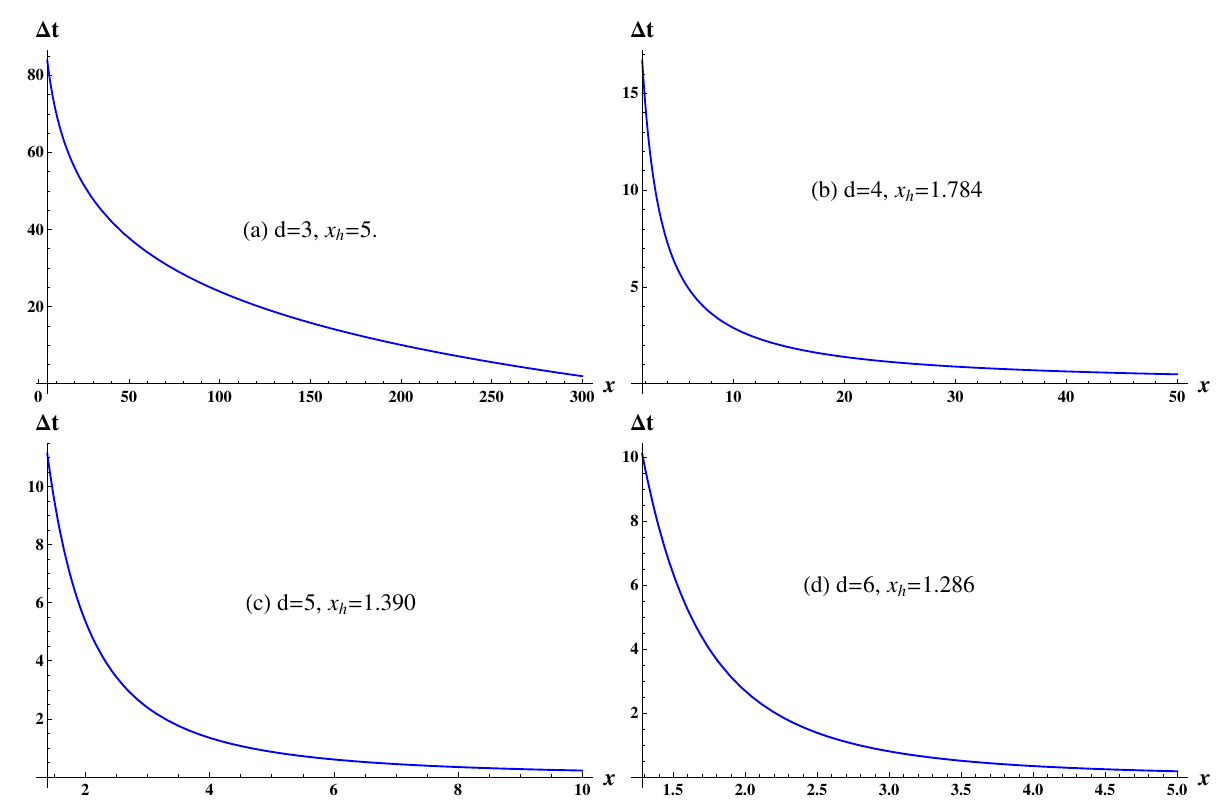
Figure 6. Excess time delay for a higher dimensional Schwarzschild black hole with α = 1.5, η = 2.5, δ = 100 and σ = 100. In the case of maximum excess time delay, the distances δ and σ are very greater than the location of